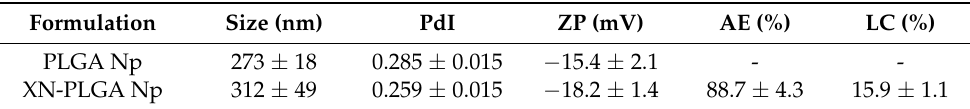
Table 1. Diameter (nm), PdI, and ZP (mV), AE, and LC of the XN-loaded PLGA nanoparticles and unloaded nanoparticles ( n = 3, mean ±